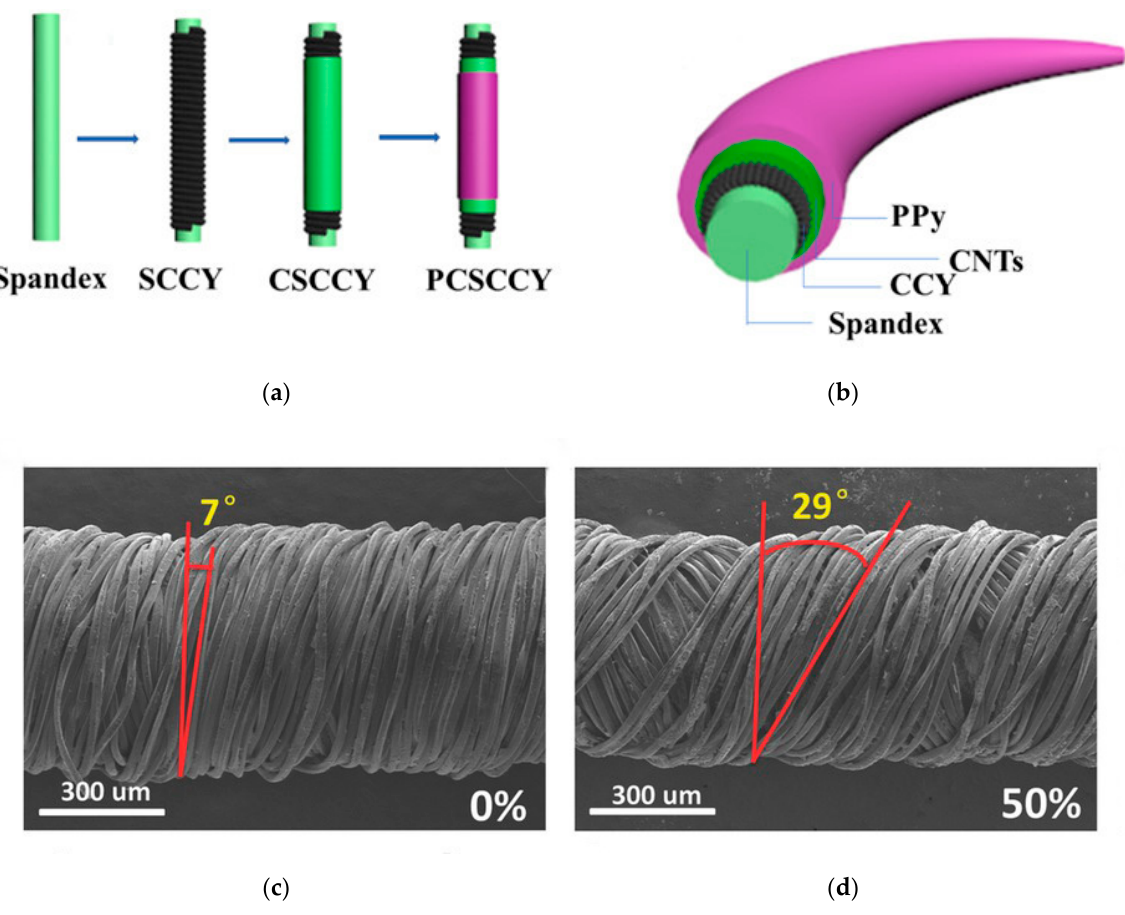
Figure 8. ( a ) Schematic diagram of rubber thread and different core-spun yarns ( b ) Cross-sectional structure of the PCSCCY yarn [95] ( c ) SEM image of PDCY-RGO under 0% strain, 7° ( d ) SEM image of PDCY-RGO under 50% strain, with the winding angle marked as 29° [96].